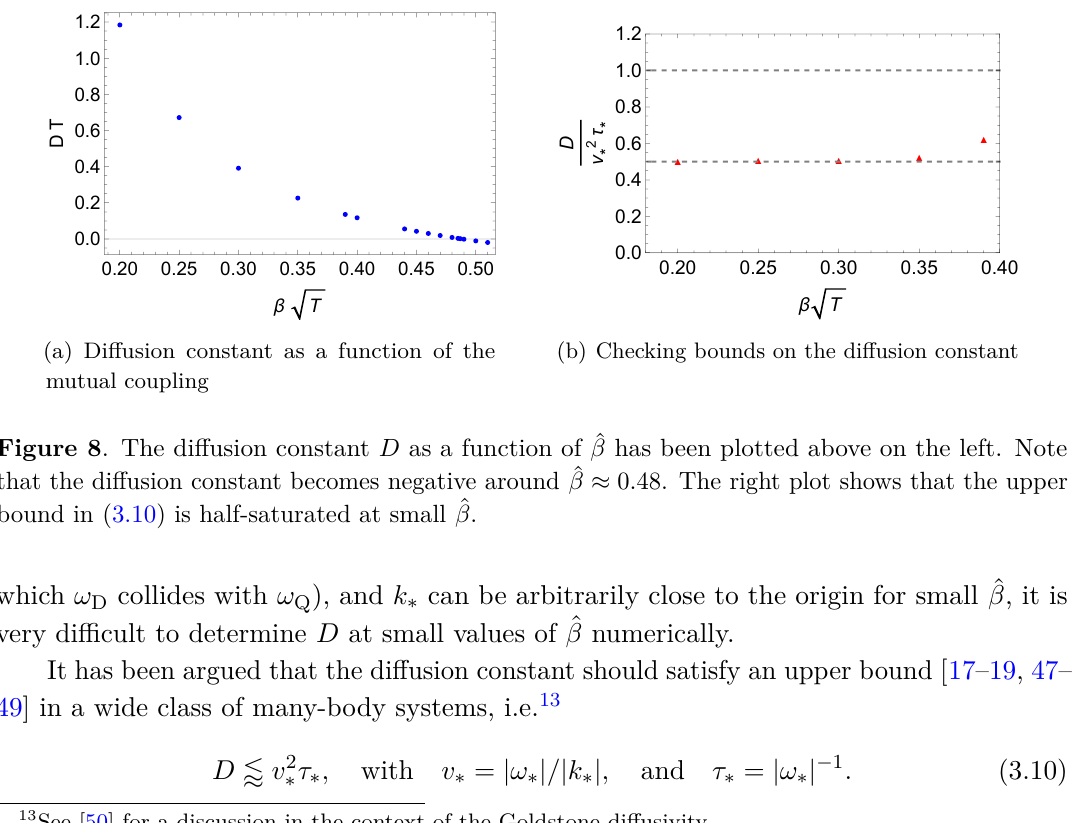
Figure 7 . Behavior of the first six QNMs in complex frequency plane with varying k at ˆ β = 0 . 5 . The arrows indicate the movement of the poles in increasing k , with each colored dot representing k = 0 , k = 1 . 1572 π and k = 1 . 5 π respectively. Unlike the cases of ˆ β = 0 . 4 shown in figure 6, the diffusive pole shown in purple has a negative diffusion constant, moves along the positive imaginary axis and collides with ω U around k ≈ 1 . 1 π, . Furthermore, all poles on the lower half plane have finite real parts for all values of k — no collision between poles take place on the lower half plane at any value of k .